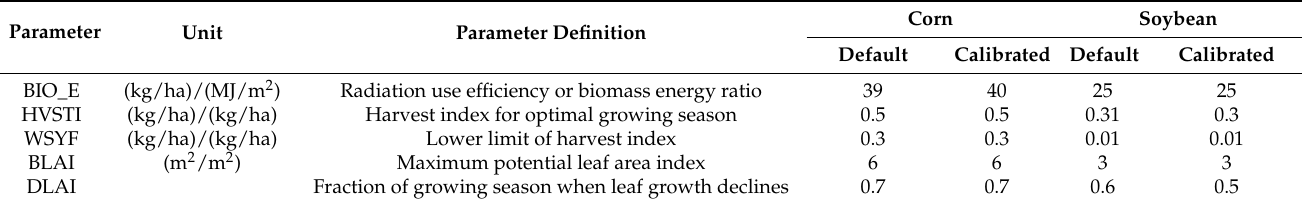
Table 3. Default and adjusted crop yield parameters for corn and soybean applied at HRU scale. The model parameters name and their definitions are listed according to SWAT input–output documentation [27].